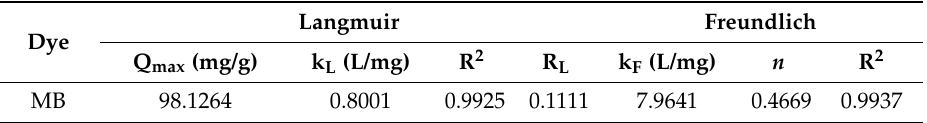
Figure 8. Langmuir isotherm model ( a ) and Freundlich isotherm model ( b ) for the MB adsorption by CCT-BFO. The pH values of the MB aqueous solutions are 7. Table 2. Parameters, for the adsorption of MB onto CCT-BFO, of the Freundlich and Langmuir isotherm models.